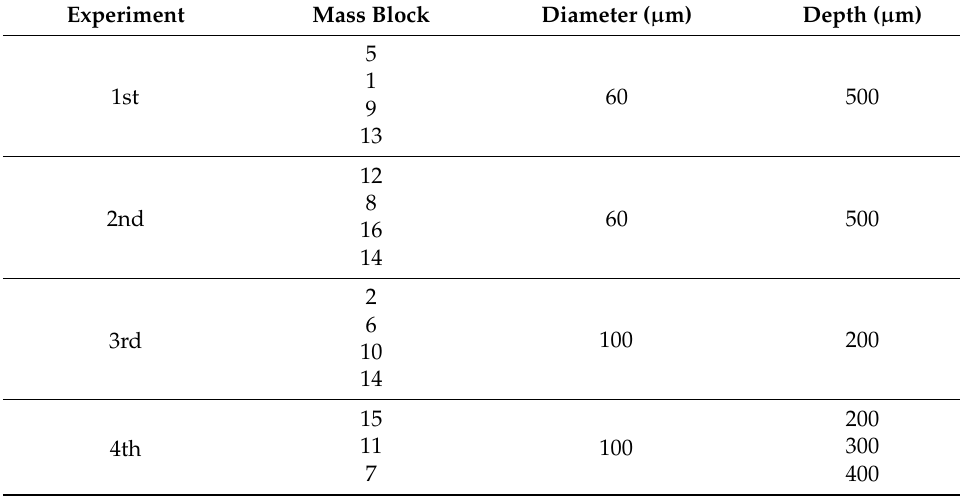
Table 6. Tuning parameters in the